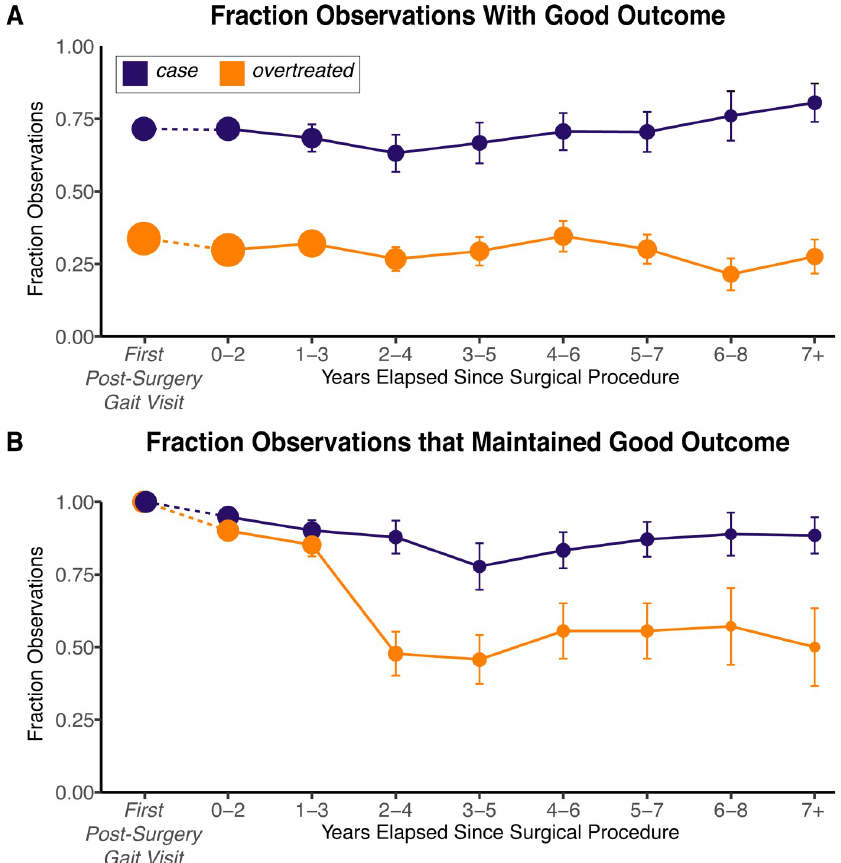
Fig 6. Long-term outcomes following gastrocnemius lengthening surgery in case and overtreated limbs. Observations were labeled as good outcomes if either the improvement in ADI with respect to the pre-surgery gait visit was at least five points, or if the ADI was greater than the pre-surgery visit ADI and at least 90. (A) These observations were binned based on years elapsed following the gastrocnemius lengthening procedure, and rate of good outcome in each bin was computed. (B) Observations were filtered based on whether the limb was labeled as a good outcome at the post-surgical gait visit to examine if the observed outcomes immediately following surgery were maintained over time. The error bars represent ± 1 standard error for the computed fraction. The areas of the dots in (A) and (B) are proportional to the number of observations included in that bin.